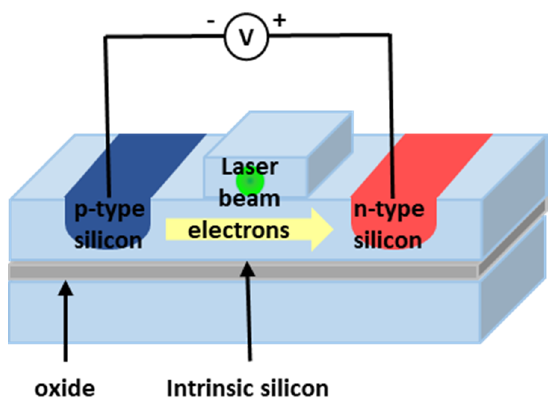
Figure 4. Typical configurations of silicon-on-insulator (SOI) waveguide Raman laser.